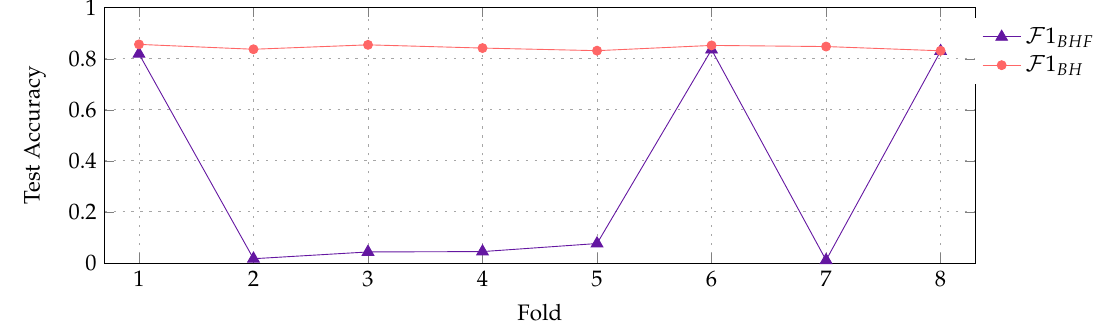
Figure 6. Classifier training under the BHF feature combination is much less stable than classifier training under the BH feature combination only (here: F 1 BHF and F 1 BH for L 2). For all folds, training converges quickly under all three feature transformations.